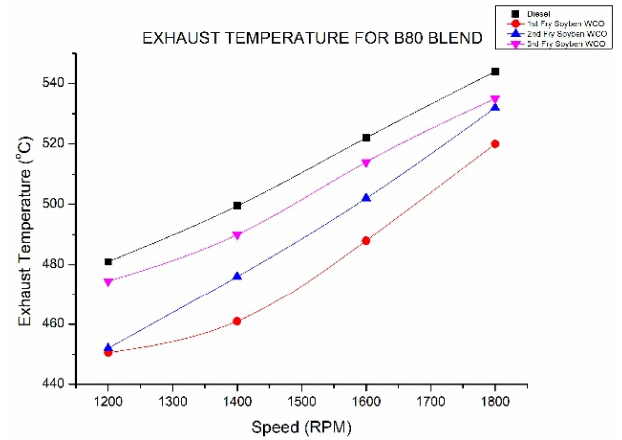
Figure 13. Exhaust temperature of different fry oils (B80 blend) at different rpm.